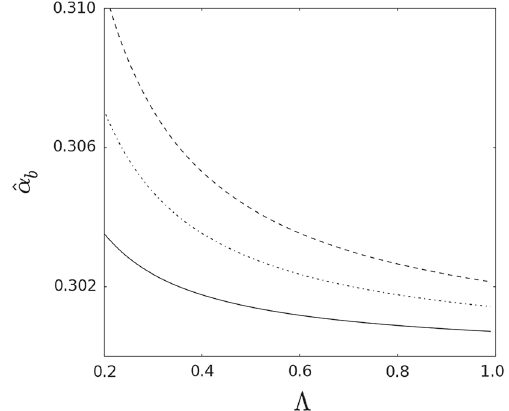
Fig. 4 Plot of ˆ α b vs. Λ for J r / M 2 = 0 . 1 (continuous line), J r / M 2 = 0 . 2 (dot-dashed line) , and J r / M 2 = 0 . 3 (dashed line). We assumed b / 2 M = 10, sin χ = 1, and ω 2 e /ω 2 = 0 .